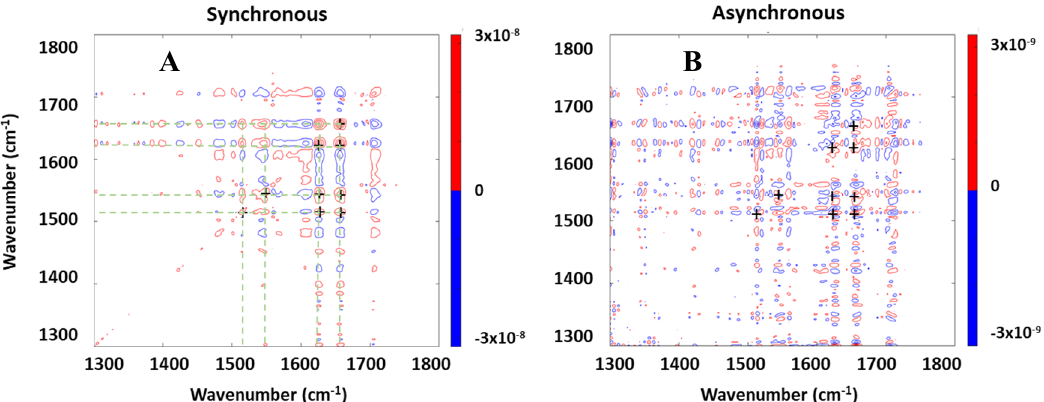
Figure 3. 2D correlation spectroscopy analysis of the spectral changes in a single SH-SY5Y cell exposed to 100 µ g / mL of MAPbI 3 for five days. ( A ) Synchronous plot. The crosses identify the main peaks under discussion, at 1655, 1627, 1548, and 1515 cm − 1 , along the diagonal, and the corresponding cross-peaks. The dashed green lines are used to guide the eye to the wavenumber scale. The Z scale (correlation) is in arbitrary units. Positive values of the correlation peaks (red color) indicate in-phase correlation; negative values (blue color) indicate opposite-phase correlation. ( B ) Asynchronous plot. The crosses identify the same locations marked in the synchronous plot.